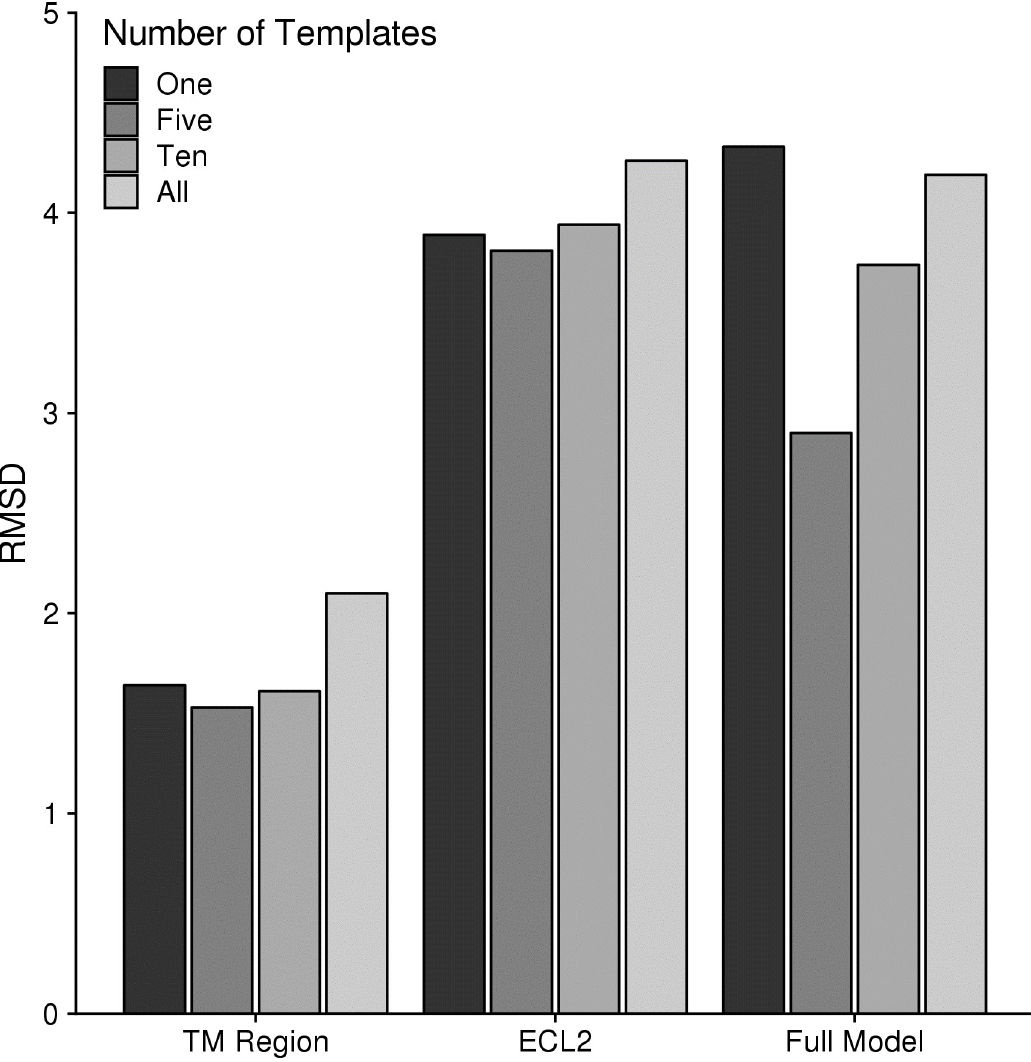
Fig 5. Comparison of model accuracy using various numbers of starting templates. For each target, 1000 models were generated using either 1, 5, 10, or all available templates. The average RMSD is plotted for the TM region, ECL2, and the Full